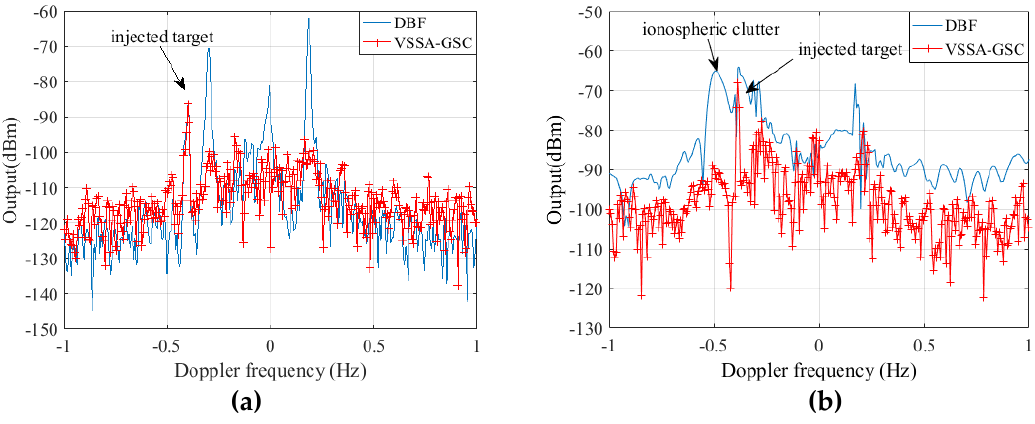
Figure 6. Doppler frequency profile: ( a ) visible target without clutter; ( b ) target submerged with clutter